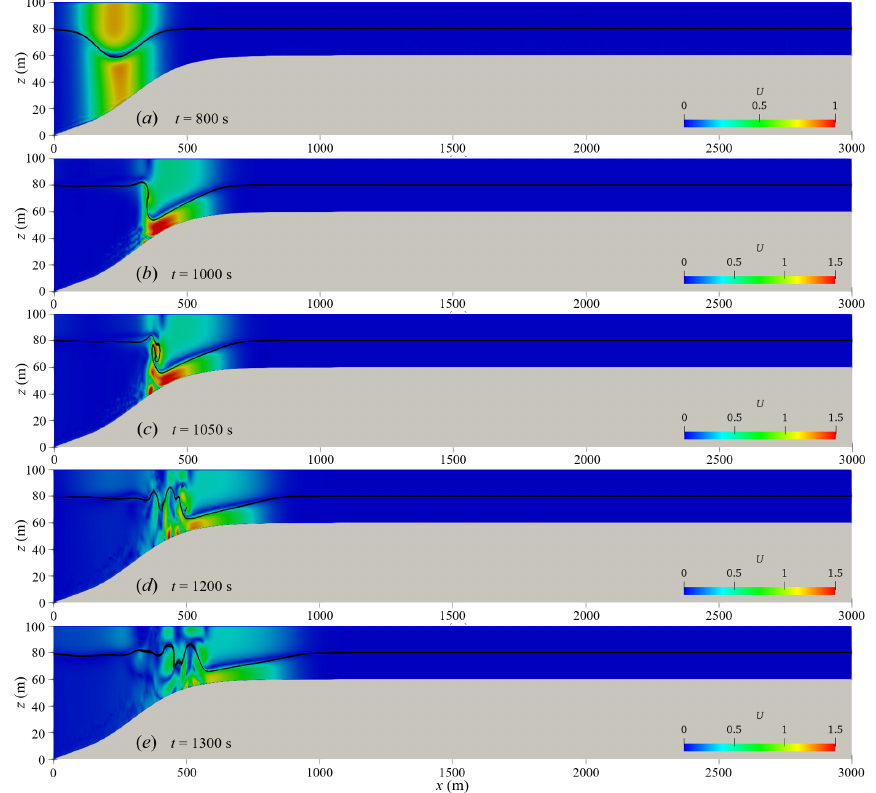
Figure 20. Velocity field diagram of ISW propagation (the black solid line is the iso-density contours, t = 800 to 1300s).